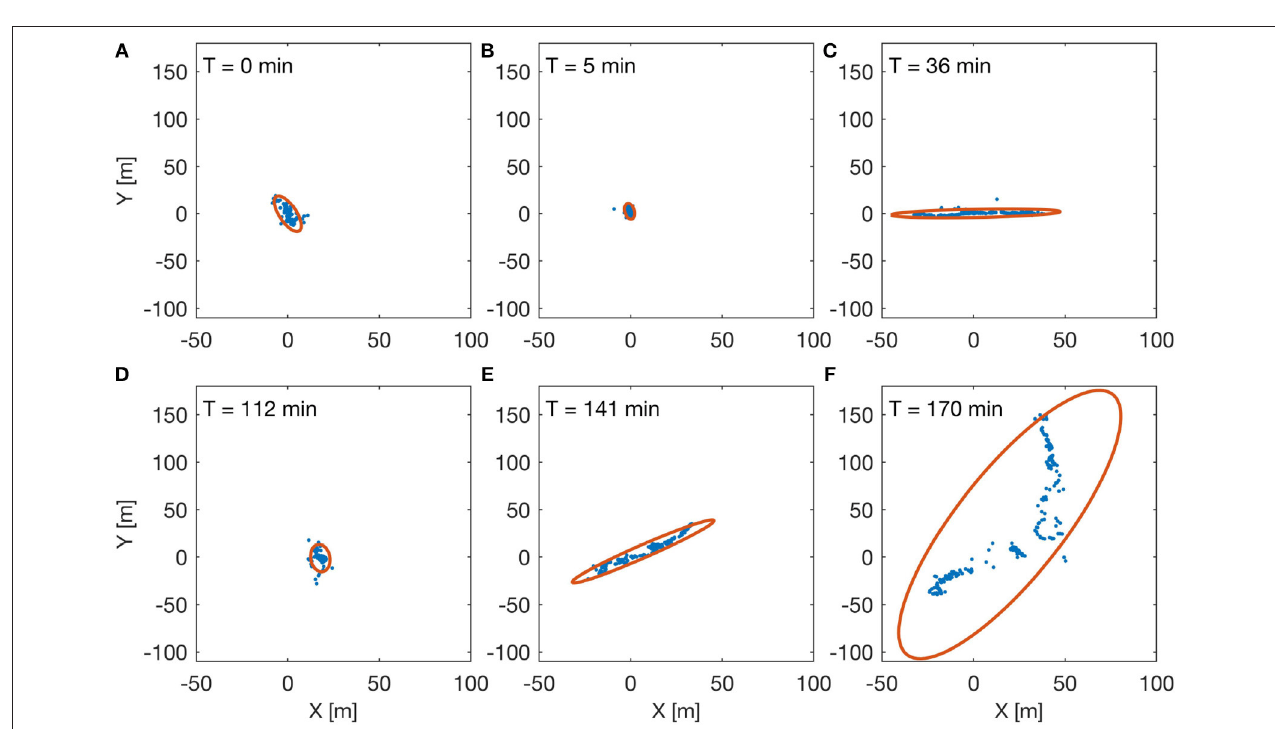
FIGURE 11 | Snapshots of rectified plate positions and ellipses at (A) 0 min, (B) 5 min, (C) 36 min, (D) , 112 min, (E) 141 min, and (F) 170 min. Supplementary Video S1 shows all rectified plate positions.